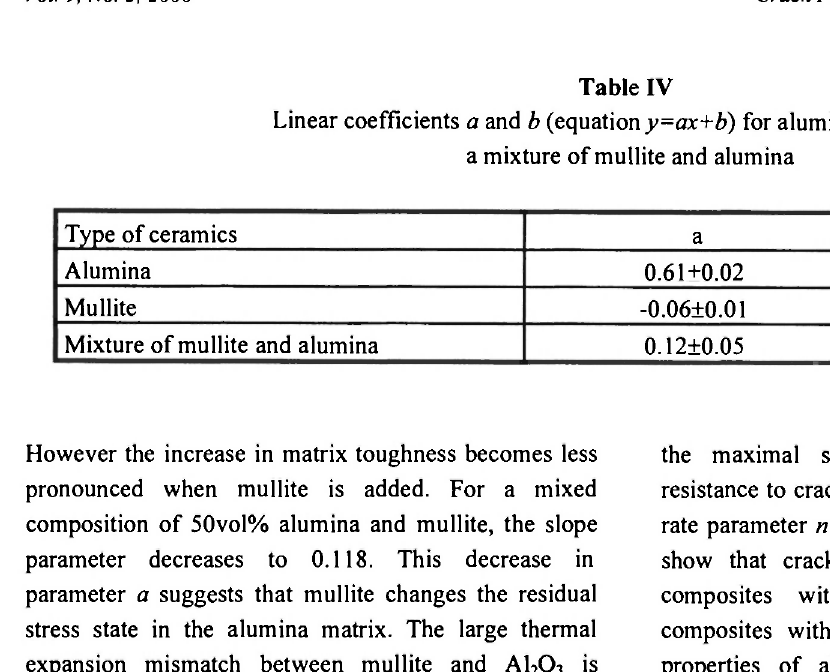
Linear coefficients a and b (equation y=ax+b) for alumina, mullite and a mixture of mullite and alumina